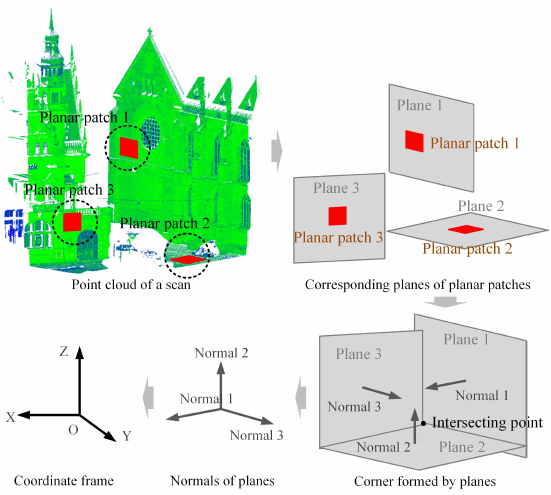
Figure 3. Coordinate frame estimation from the corner of planes to those in another scan, we believe that the transformation pa- rameters are estimated correctly from these corresponding corner pairs. In detail, a RANSAC-based strategy is applied, sampling a plane sets of three planar patches from two scans concurrently in each random selection round. The plane sets should satisfy that they are non-parallel planar patches. For each set of triple planar patches, a coordinate frame can be generated, an illustration of which is shown in Fig. 3.